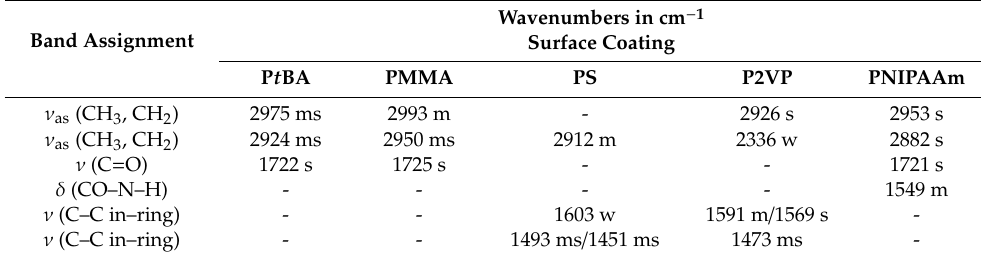
Figure 7. ( A ) ATR-FTIR spectra—black line: MPTS@MCNP; red line: P t BA@MPTS@MCNP; green line: PMMA@MPTS@MCNP; blue line: PS@MPTS@MCNP; cyan line: P2VP@MPTS@MCNP; pink line: PNIPAAm@MPTS@MCNP. ( B ) Enlargement of the region within the spectra where functional groups can be assigned. Table 3. Assignment of selected IR-bands of polymer@MPTS@MCNP